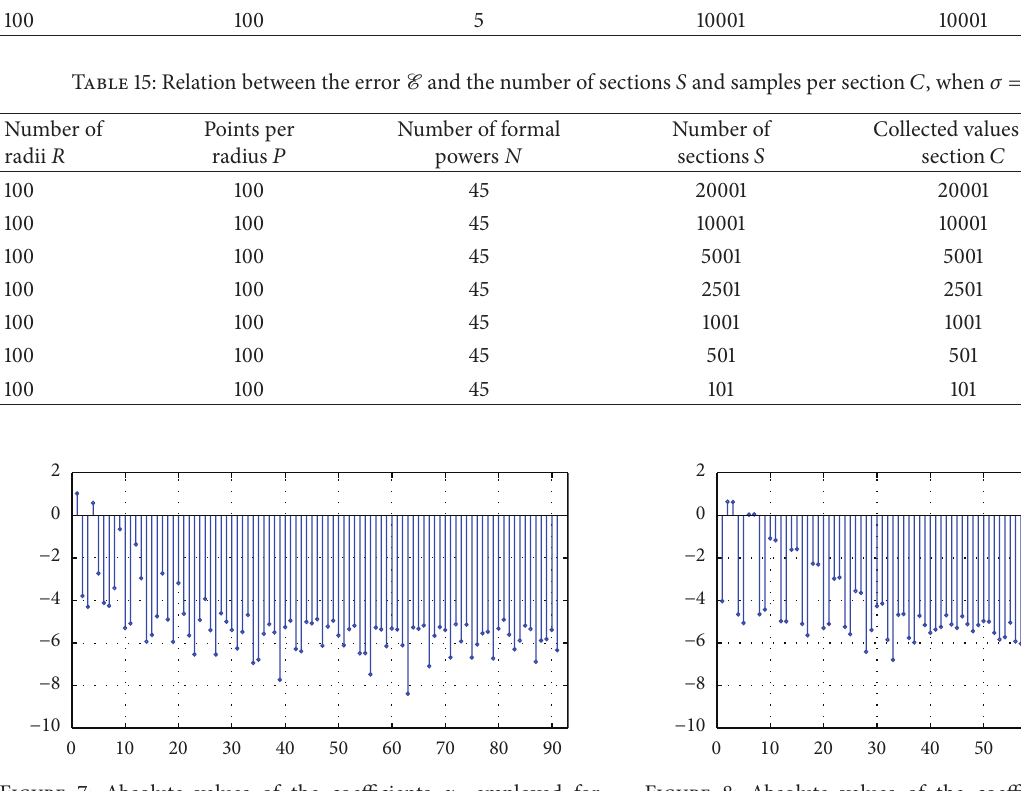
Figure 8: Absolute values of the coefficients 𝛼 𝑛 employed for approaching the boundary condition 𝑢| Γ = (1/3)(𝑥 + 𝑦) 3 + 0.1(𝑥 + } corresponding to the conductiv- 𝑦) , utilizing the base elements {𝑢 𝑛 ity function 𝜎 = 𝑒 𝑥𝑦